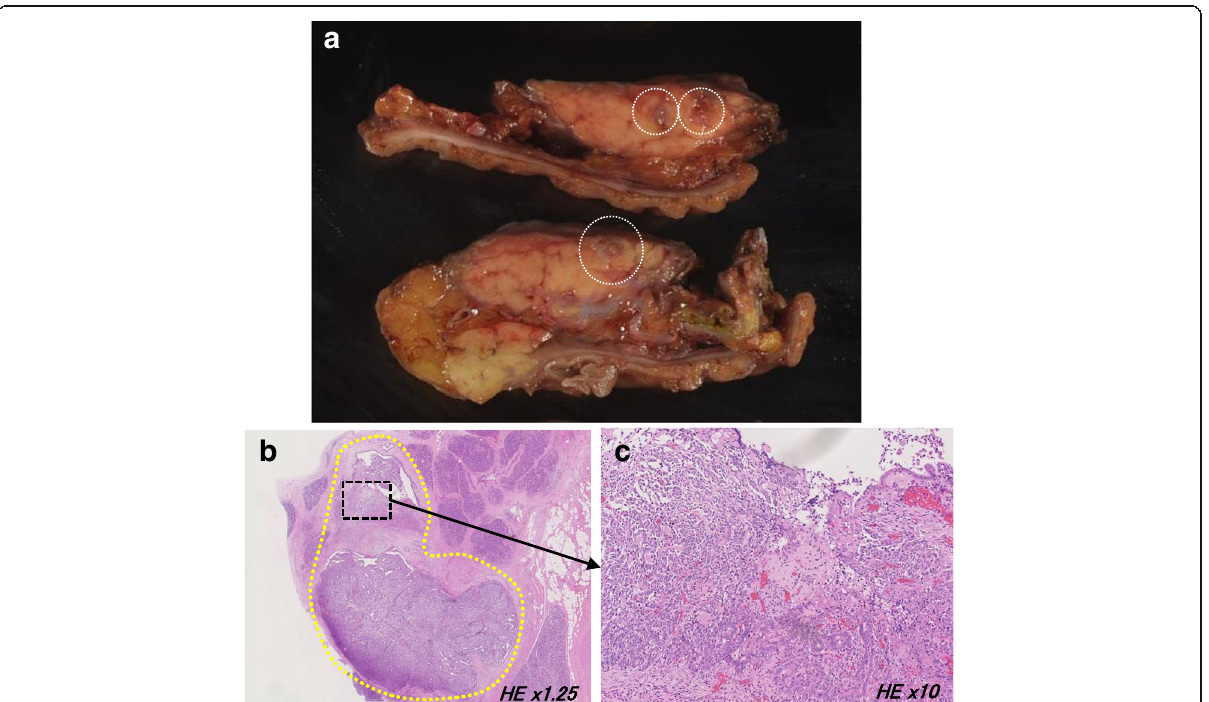
Fig. 2 Macroscopic and histopathological findings of the resected specimen in the first surgery. a Macroscopic findings showed that the tumor filled the pancreatic duct. b , c There was a tumor growing with tubular or cribriform features in the vascular stroma at the main pancreatic duct. The tumor was accompanied by necrosis in some locations and invaded the stroma around the main pancreatic